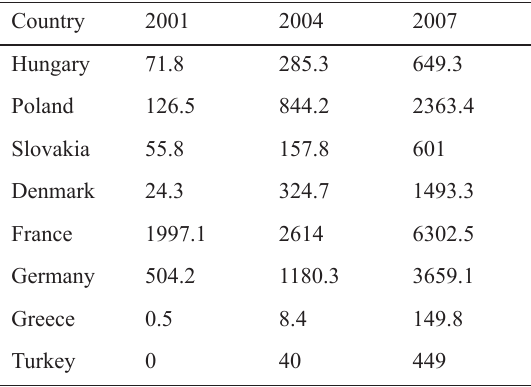
table 1. Foreign real estate investment inflows in selected oeCD countries (millions of